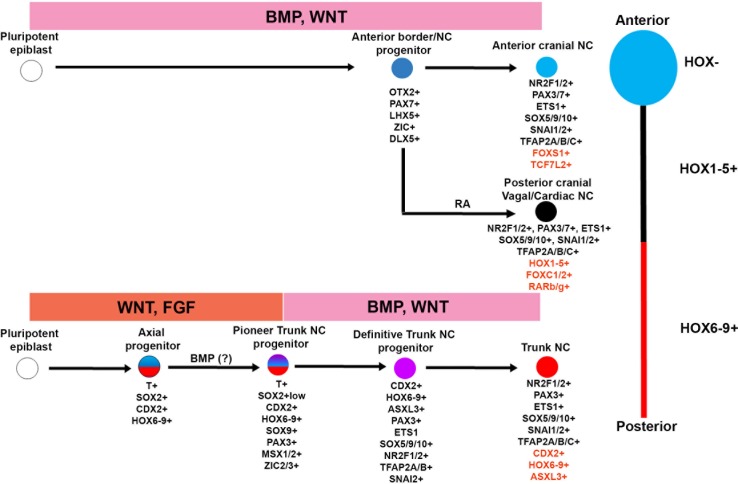
A-P patterning of in vitro derived human NC cells.Diagrammatic model summarising our findings on the in vitro generation of NC subtypes of distinct A-P identity from hPSCs. Examples of unique genes that were found to mark each NC population exclusively are shown in red.